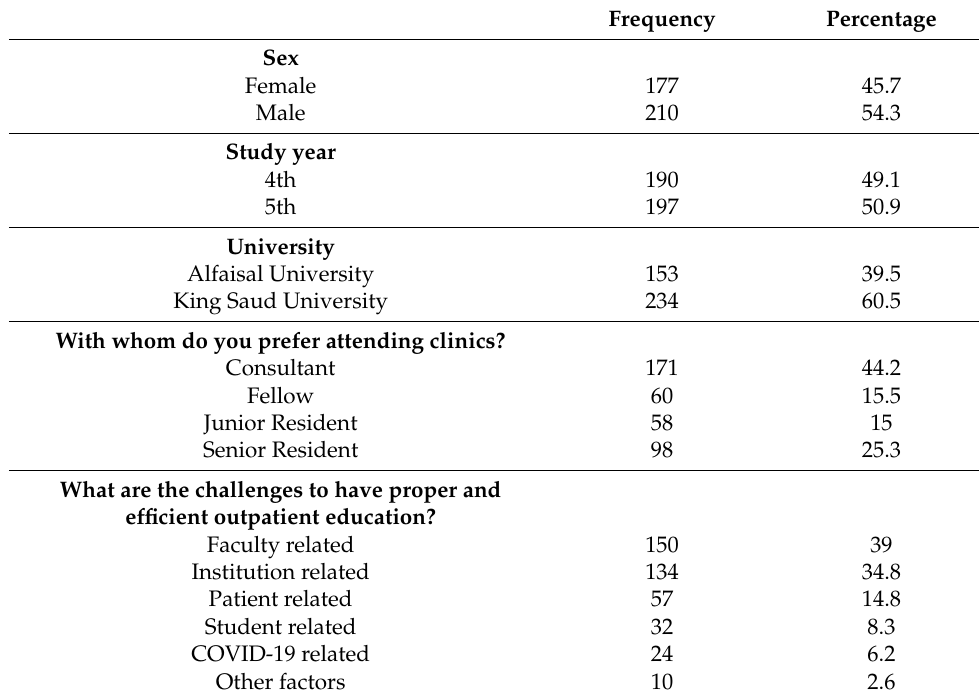
Table 1. Descriptive analysis of medical students’ demographic ( n =